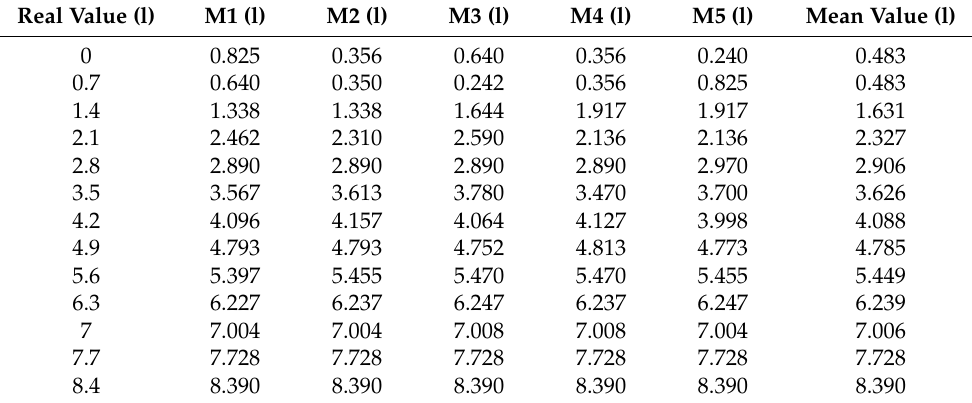
Figure 12. Mean value and variation of each measurement. Table 1. Results obtained from measurements for system validation.